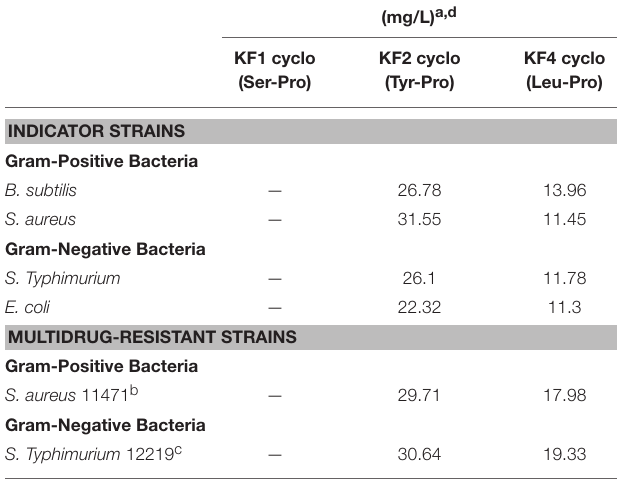
TABLE 7 | Antibacterial activity of identified CDPs from starter kimchi against Gram-positive and Gram-negative bacterial indicators and multidrug-resistant